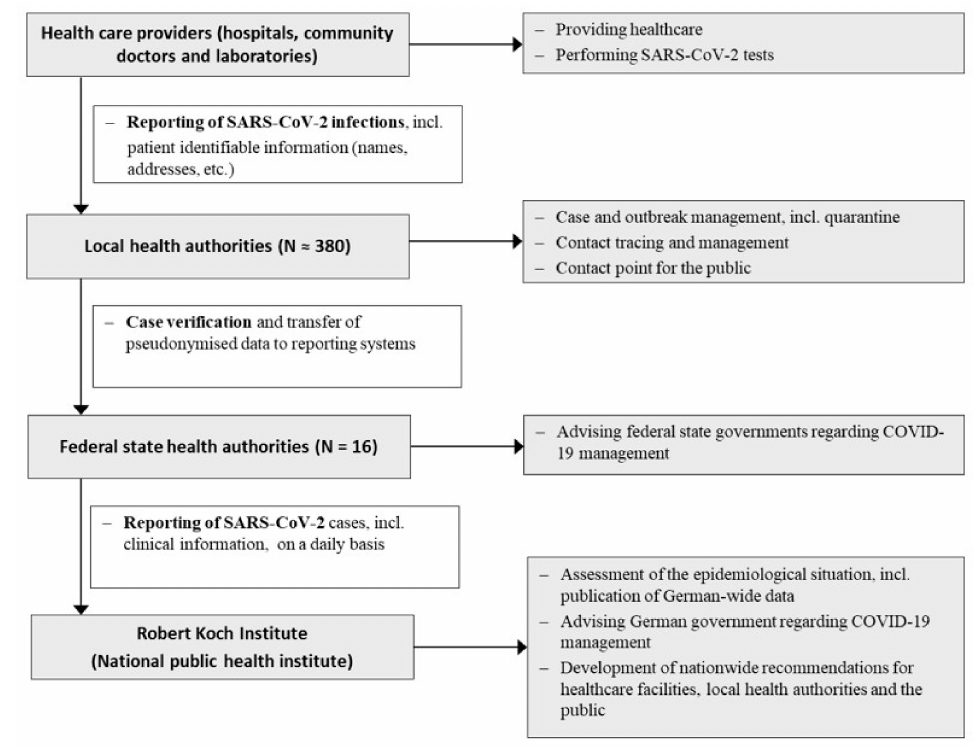
Figure 2. Public health system, outbreak management and reporting system in Germany.